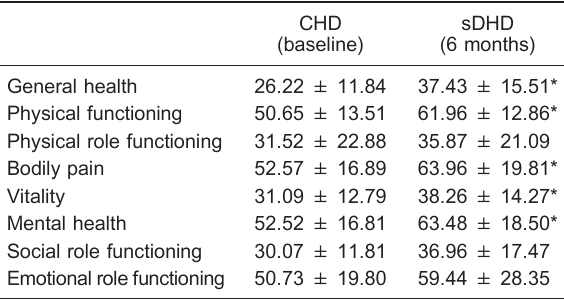
Table 3. Changes in the quality of life after conversion from CHD to